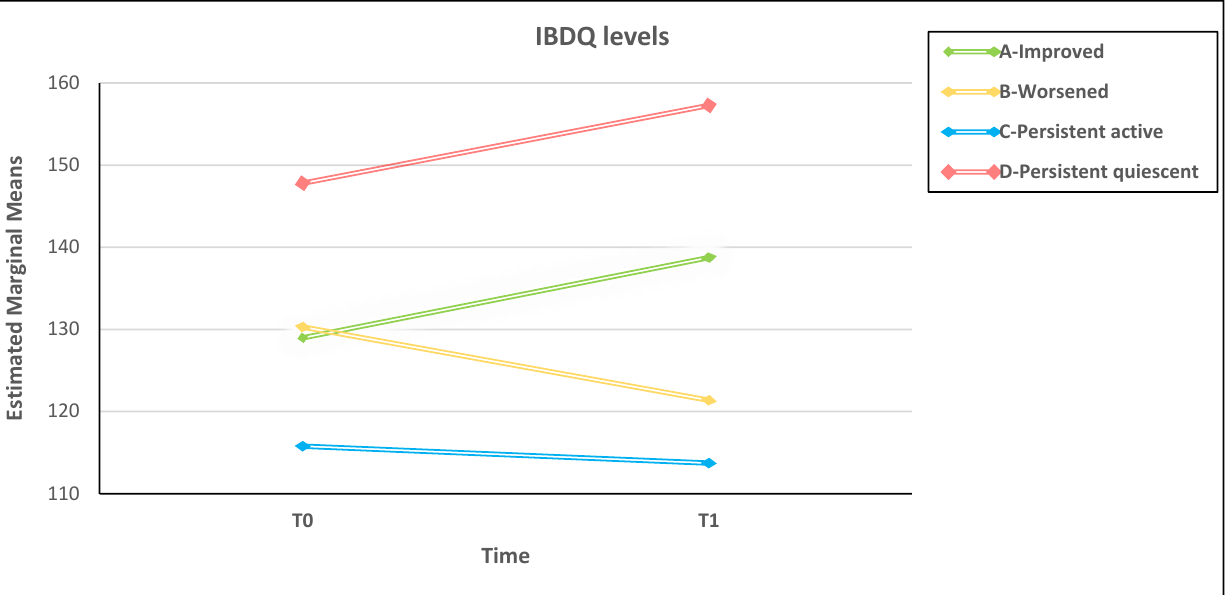
Figure 2. Over time HRQoL in the four disease activity change-related groups adjusted for baseline levels of post-traumatic